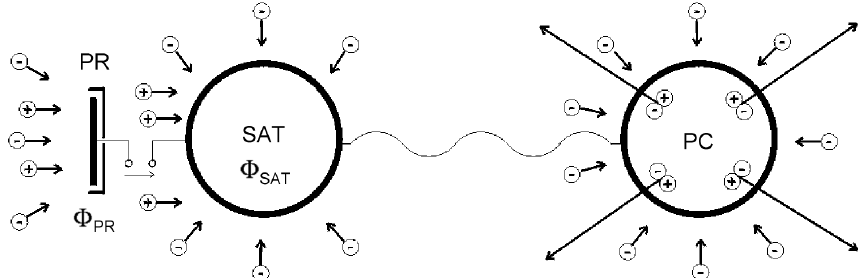
Fig. 3. Schematic drawing of our current system.